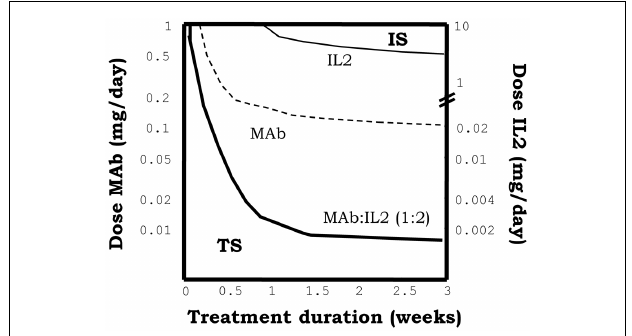
FIGURE 9 |The graph shows the minimal effective dose of mAb (left y axis) or IL2 (right y axis) versus treatment duration, required to induce the transition to the IS in a system initialized in theTS, for the treatment with immune-complexes formed with face alpha mAbs in the optimal molar proportion 1:2 (mAb:IL2) . For direct comparison the equivalent curves obtained for treatments with the same mAbs alone or the IL2 alone are also depicted. It can be seen that the injection of this class of immune complex is more efficient than the injection of the mAb or the IL2 alone to breakdown tolerance in an initial tolerant system, i.e., it requires less dose of either the mAbs or IL2 as compared to the independent